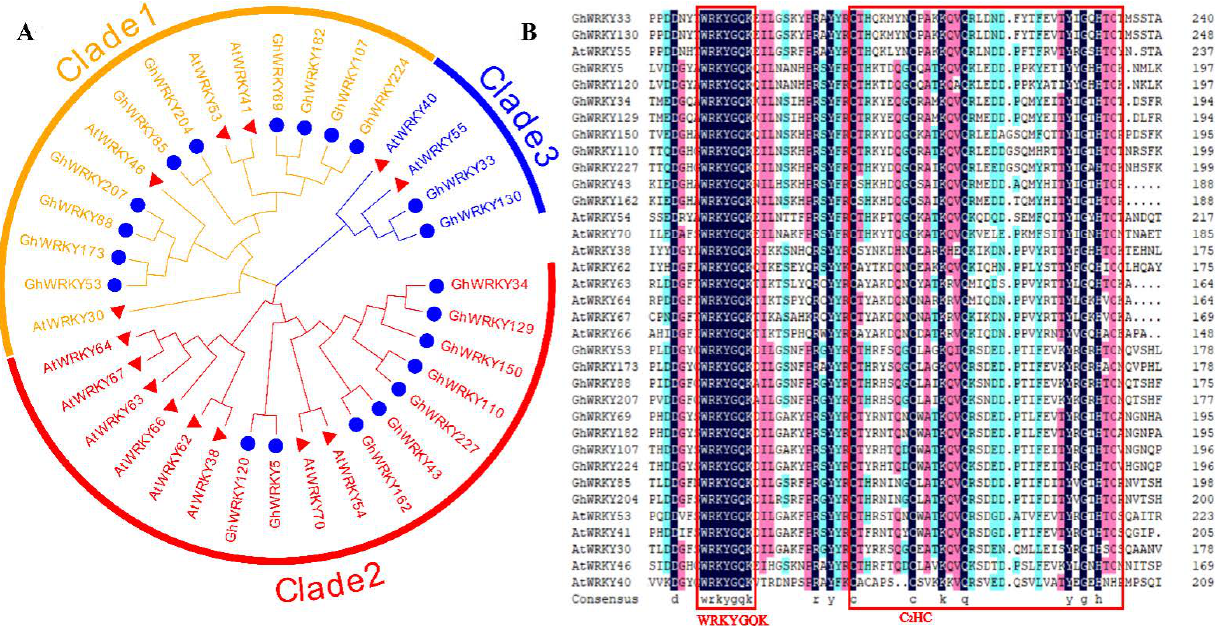
Figure 2. Phylogenetic analysis. ( A ) The phylogenetic tree of the amino acid sequences of putative group III WRKY amino acid sequences in G. hirsutum L. and A. thaliana , which was constructed by MEGA X software with the neighbor-joining (NJ) method with 1000 bootstrap replicates. GhWRKY amino acid sequences are marked by the blue circles; AtWRKY amino acid sequences are marked by the red triangles. ( B ) Multiple alignment of the amino acid sequences of putative group III WRKY in G. hirsutum L. and A. thaliana . The red box represents the conserved domain (WRKYGQK) and the C 2 HC zinc finger motif of putative group III WRKY amino acid sequences in G. hirsutum L. and A. thaliana , re- spectively.